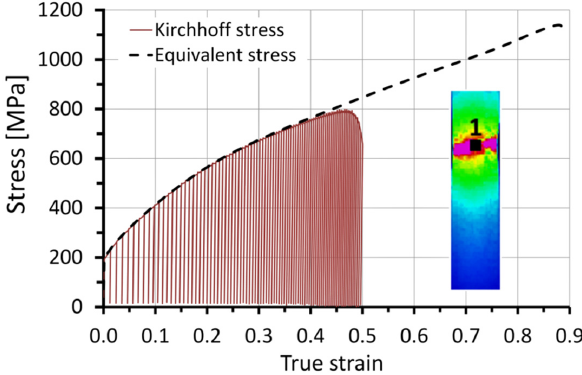
Figure 8. Kirchhoff and equivalent stress dependency, along with a thermal image of the tested specimen before fracture. specimen before